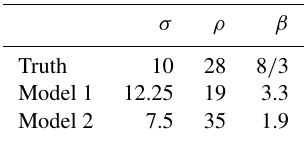
Table 2. Weights of the supermodel of the Lorenz 63 system.